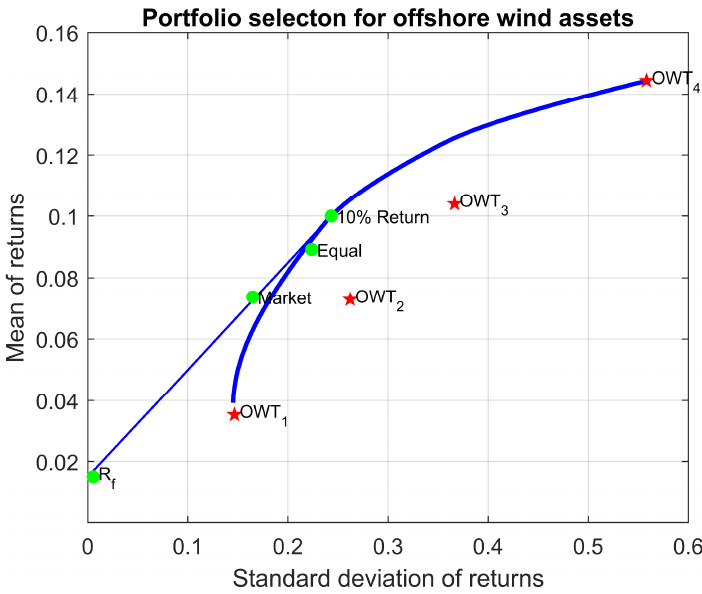
Figure 10. Mean value of ROI as a function of standard deviation, 10% return and equal weights.